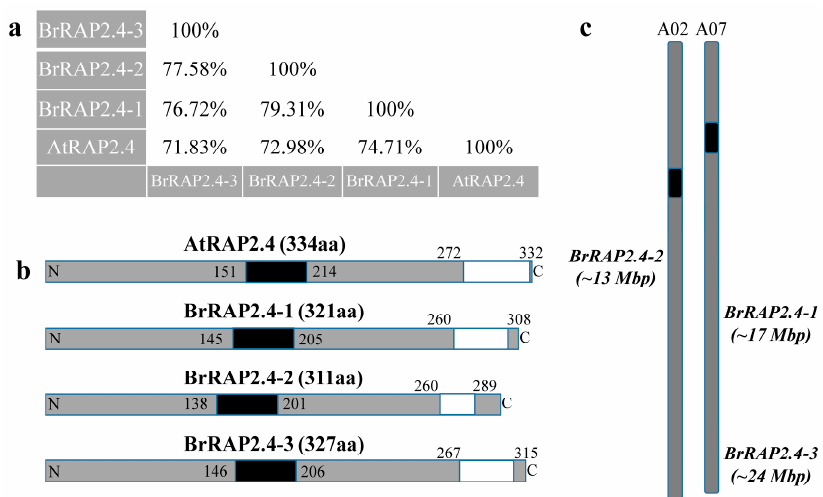
Figure 1. Comparison of Arabidopsis and B. rapa RAP2.4-like proteins. ( a ) Degrees of identity of the amino acid sequences from AtRAP2.4 and three orthologs from B. rapa. Analyses were performed online using the ClustalW program for sequence alignment, and the SIAS tool ( http://imed.med.ucm.es/Tools/sias.html ) for identity scores. ( b ) Schematic drawing of RAP2.4 proteins from Arabidopsis and B. rapa showing their length and the positions of the AP2 DNA binding domain (black box), and the predicted PEST motifs (white box). ( c ) B. rapa chromosome A02 and A07 with the predicted locations of BrRAP2.4-1 to -3 , respectively.